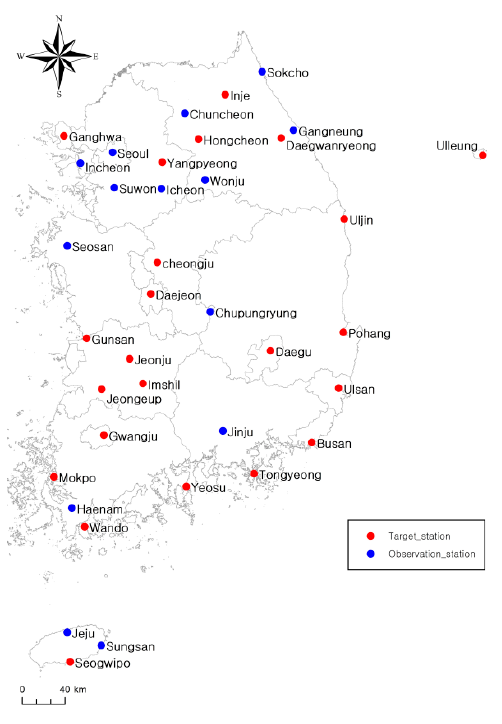
Figure 14. Target stations.